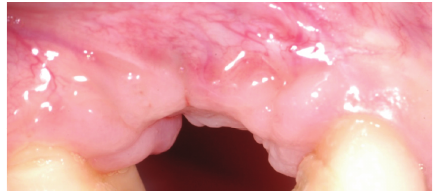
Figure 13: Soft tissues defect after 4 months of healing.